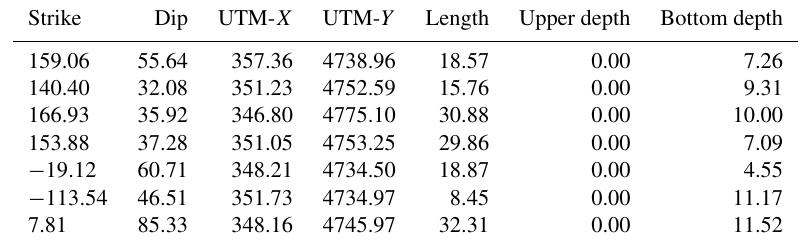
Figure 6. Fault geometry identification and plane fitting. (a) A three-dimensional view of seven identified fault segments and an aftershock point cloud. Thick lines represent the surface traces of the faults, and the dashed lines are the underground fault boundaries. (b) Projections of the 3-D aftershocks. Red dashed lines denote the seven fitted fault planes. Table 1. Geometry parameters of the inferred fault from the aftershock point cloud. Strike and dip are given in degrees; all other parameters are measured in